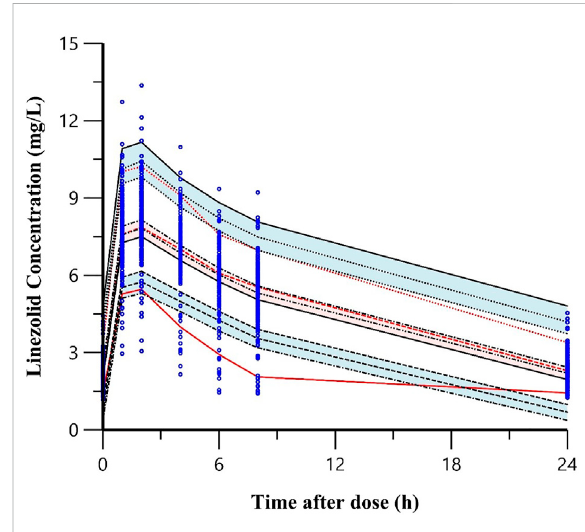
FIGURE 3 Visual predictive check plotsof the fi nal model for linezolid in the development cohort. Note: The top, middle, and bottom solid lines were the 95th,50th and 5th percentiles of the observed data, respectively. The shaded areas from top to bottom were the 95% con fi dence interval for the 95th, 50th, and 5th percentile of the simulated data. The dots were the observed concentrations.